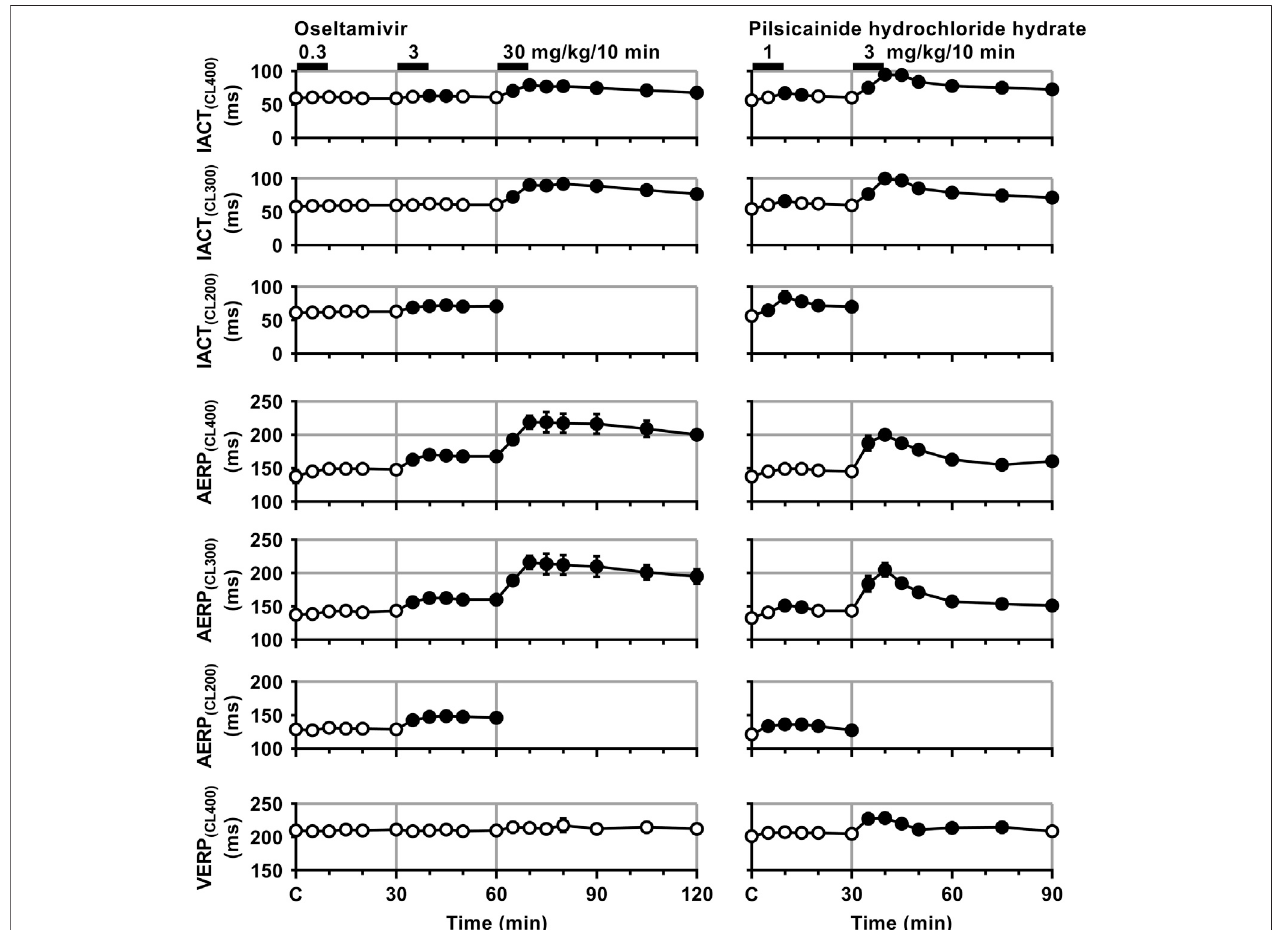
FIGURE 4 | Time courses of changes in the inter-atrial conduction time (IACT) at pacing cycle lengths of 400 ms (IACT (CL400) ), 300 ms (IACT (CL300) ) and 200 ms (IACT (CL200) ); atrial effective refractory period (AERP) at basic pacing cycle lengths of 400 ms (AERP (CL400) ), 300 ms (AERP (CL300) ) and 200 ms (AERP (CL200) ); and ventricular effective refractory period (VERP) at a basic pacing cycle length of 400 ms (VERP (CL400) ) after the administrations of oseltamivir (left) and pilsicainide hydrochloride hydrate (right) . Data are presented as mean ± S.E.M. (n (cid:1) 4 for each drug). Closed symbols represent signi fi cant differences from their corresponding pre-drug basal control value (C) by p <